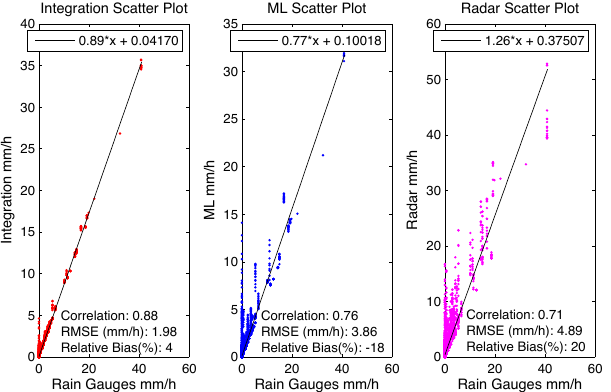
Figure 12. Rain rate scatter plots and performance evaluations of the integration (left), ML (middle) and radar (right) with respect to all the available rain gauges for event 3.